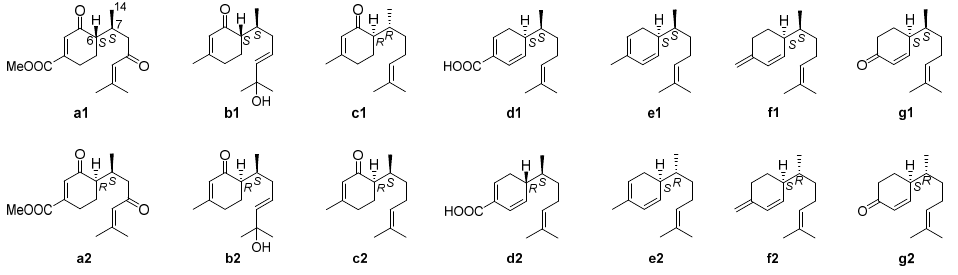
Figure 6. Chemical structures of seven pairs of bisabolane epimers. Table 3. Optical rotations of compounds a1 / a2 − g1 / g2 . Compounds Absolute Configuration Compounds Absolute Configuration Optical